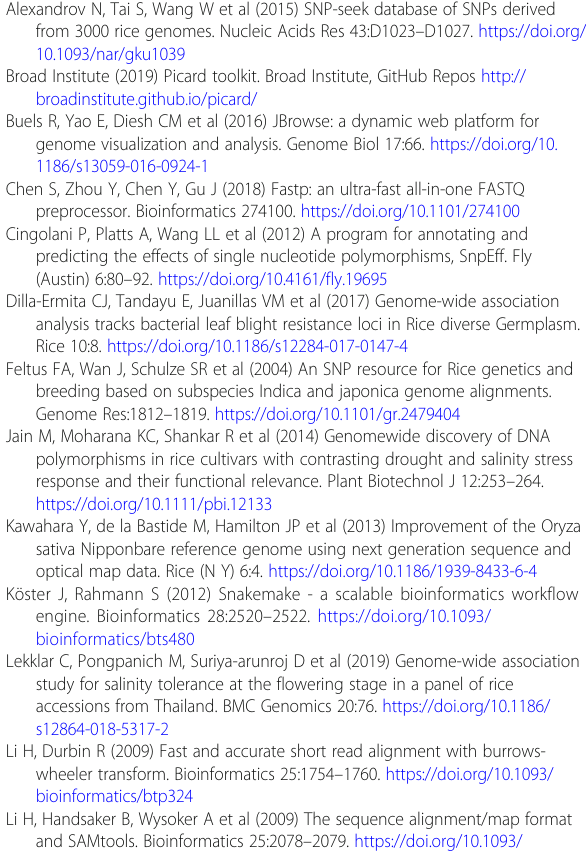
Additional file 1: Table S1. List of Rice Accessions Resistant/Susceptible to Different Biotic Stresses. Additional file 2: Table S2. List of Genes Involved in Different Biotic/ Abiotic Stress Resistance. Abbreviations GWAS: Genome-Wide Association Study; HR: Highly Resistant; HS: Highly Susceptible; JSON: JavaScript Object Notation; MR: Moderately Resistant; MS: Moderately Susceptible; nsSNP: Non synonymous SNP; QTL: Quantitative Trait Locus; R: Resistant; RSRS: Rice Stress Resistant SNPs; S: